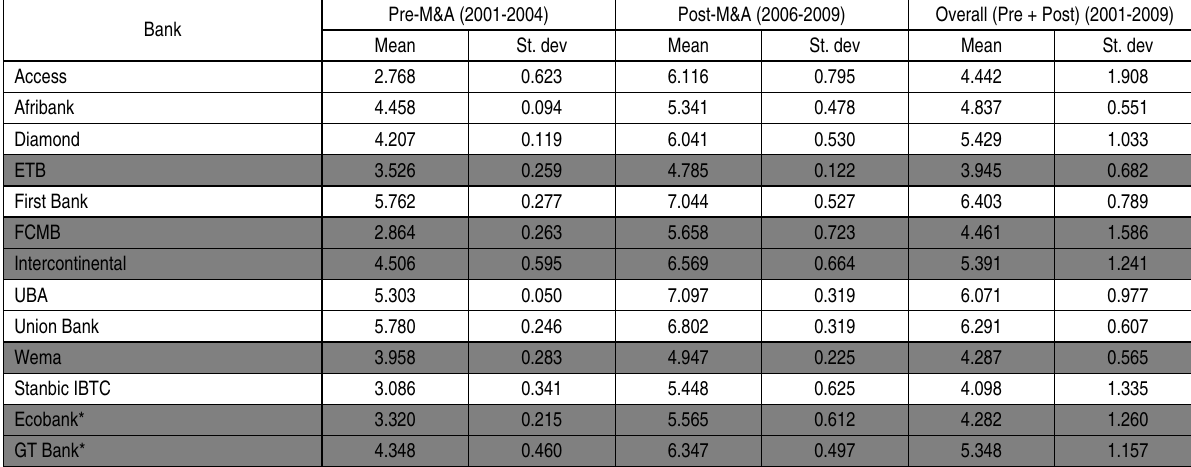
Table 1. Descriptive statistics for the 15 banks based on size (ln total